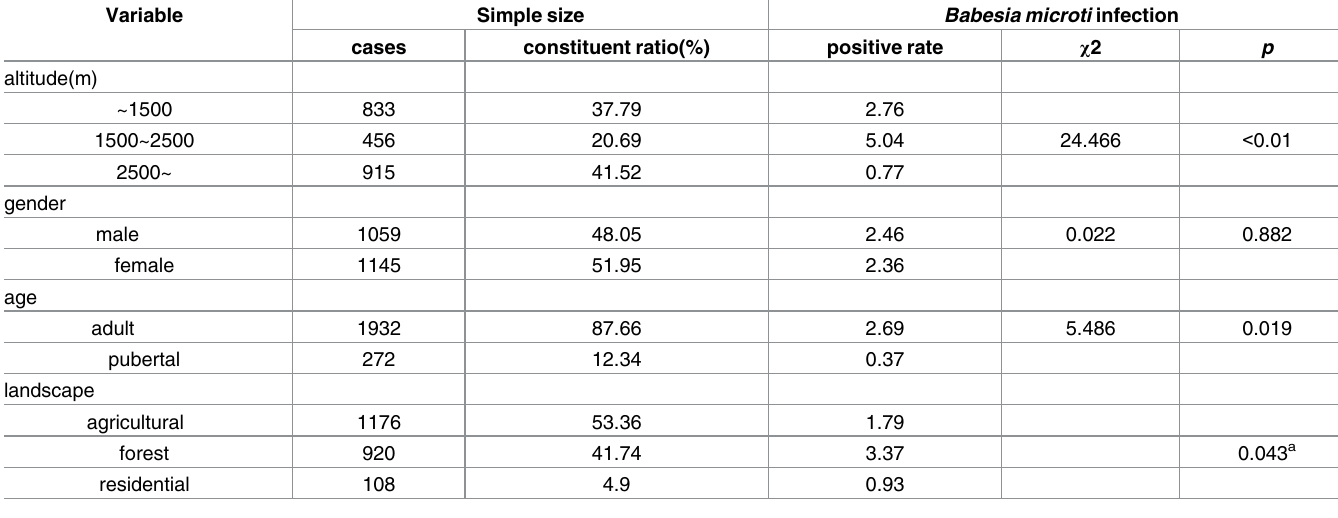
Table 3. Risk factors related to B . microti based on univariate analyses.